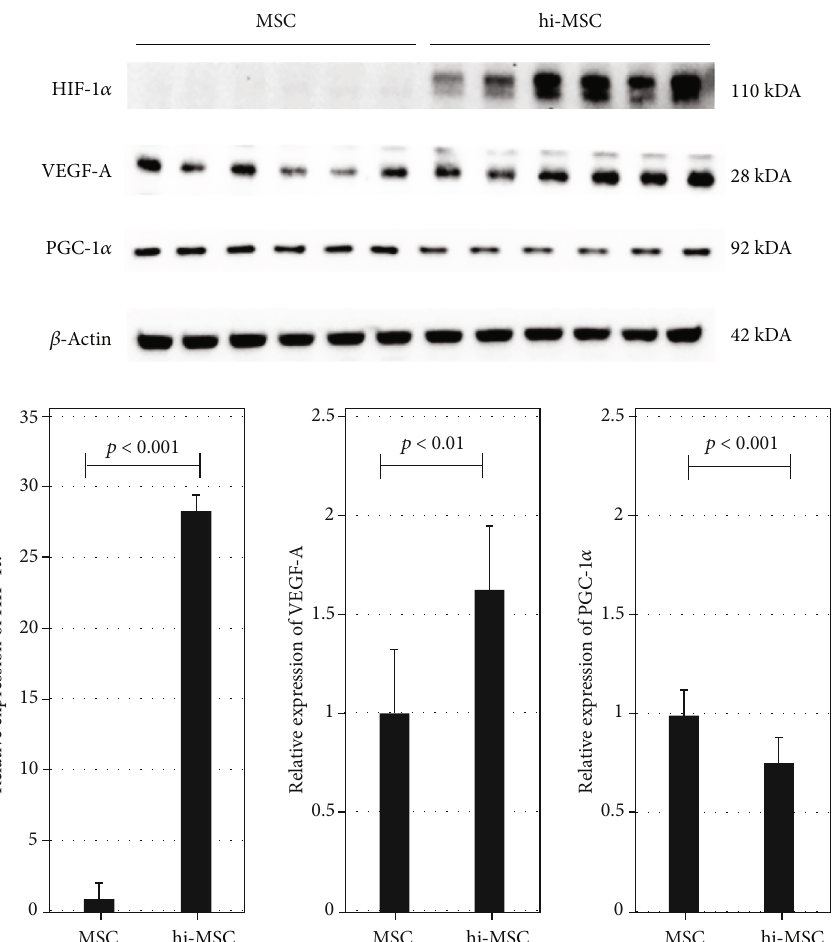
Figure 6: Expression of angiogenic cytokines in cultured mesenchymal stem cells (MSCs) and hypoxia-induced MSCs (hi-MSCs) prior to implantation. hi-MSCs showed signi fi cantly higher expression levels of hypoxia-inducible factor-1 alpha (HIF-1 α ) and vascular endothelial growth factor A (VEGF-A) than those in MSCs. The expression level of peroxisome proliferator-activated receptor γ coactivator-1 α (PGC- 1 α ) was slightly lower in the hi-MSC group than in the MSC